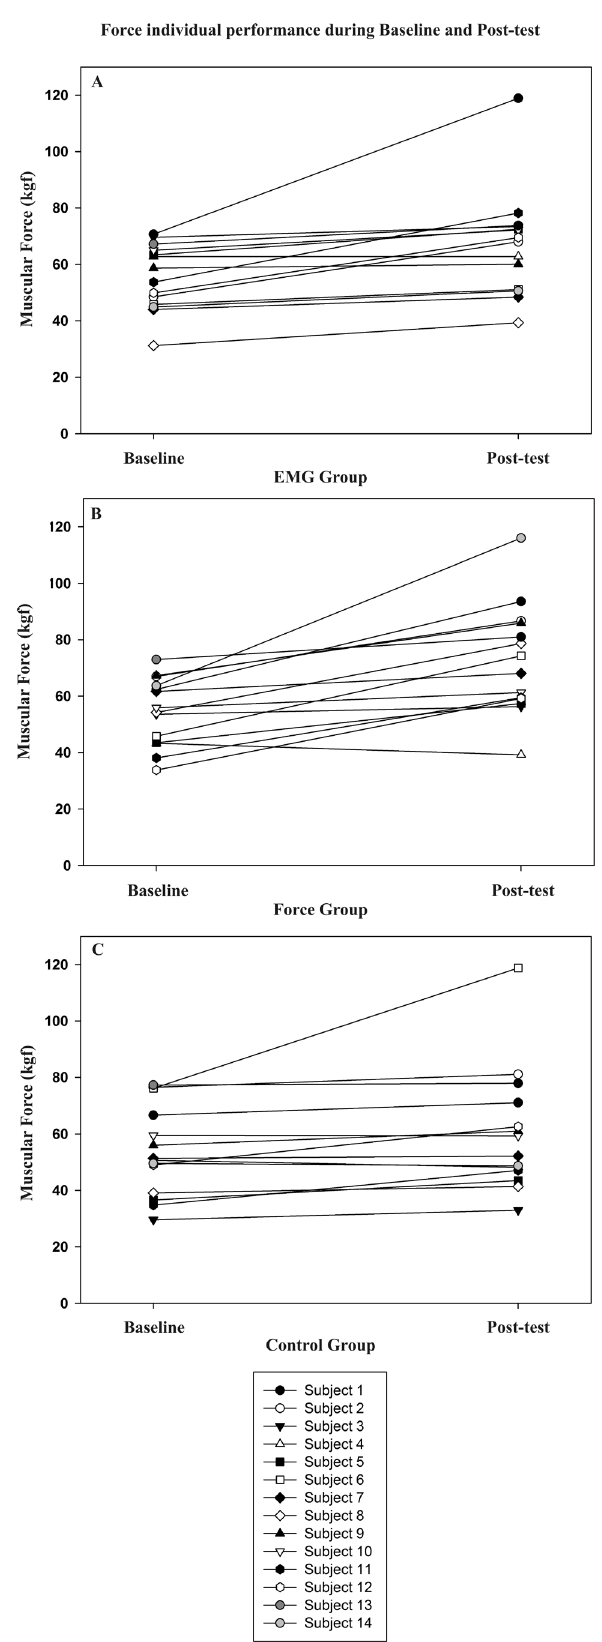
Figure 3. Force (kgf) individual performance and variability during baseline and post-test for EMG group (A), Force group (b) and Control group